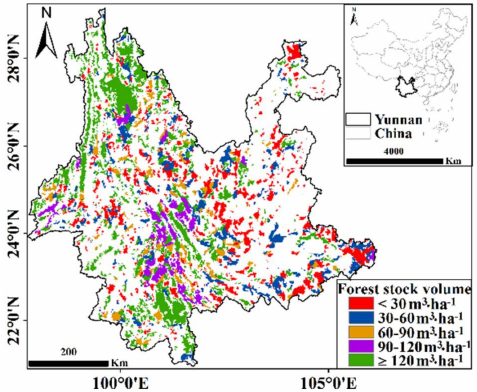
Figure 1. Distribution of forest stock volume densities in Yunnan province, China